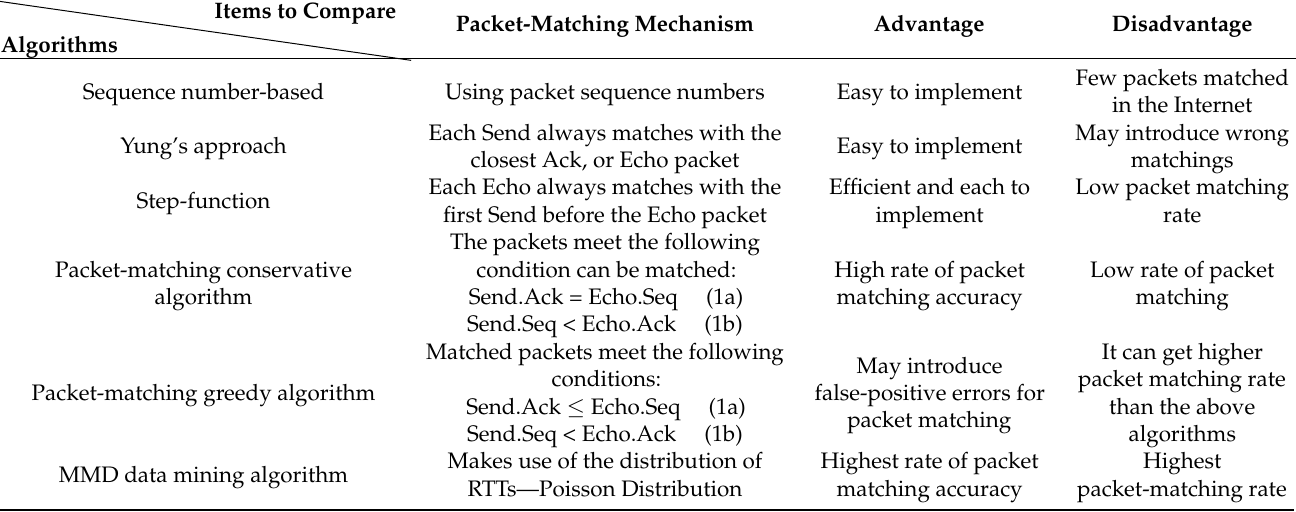
Table 5. Comparison among different packet-matching algorithms.